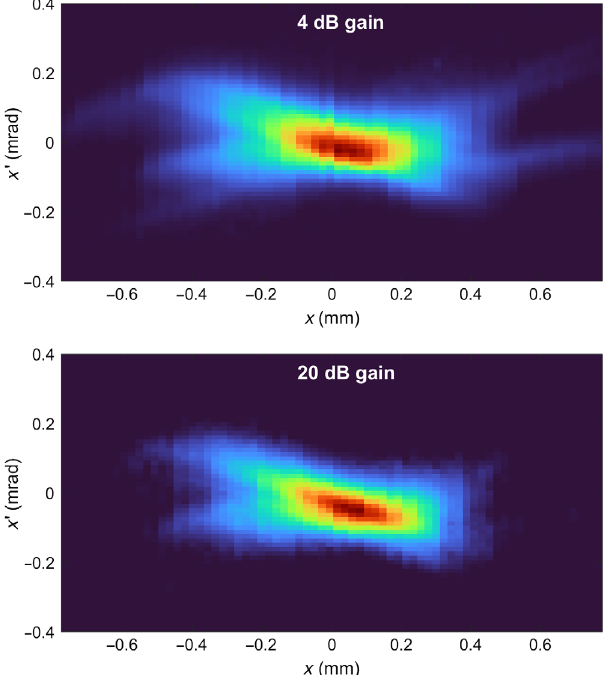
FIG. 6. 1-nC beam measured with two camera gains, unscaled rms emittances are 0 . 81 μ m at 4 dB and 0 . 53 μ m at 20 dB, respectively. The lower emittance value of the 20 dB case is a result of missing low density tails due to a higher noise floor.